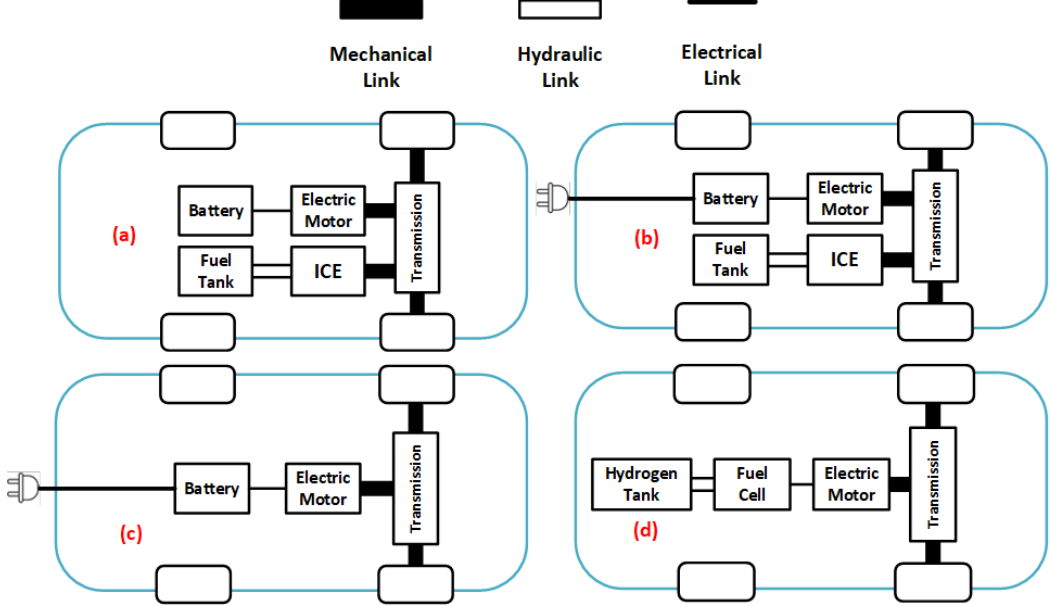
Figure 1. Basic structure of different electric vehicles (EVs) types. ( a ) Hybrid Electric Vehicle (HEV); ( b ) Plug-in Hybrid Electric Vehicle (PHEV); ( c ) Battery Electric Vehicle (BEV); and ( d ) Fuel Cell Electric Vehicle (FCEV).